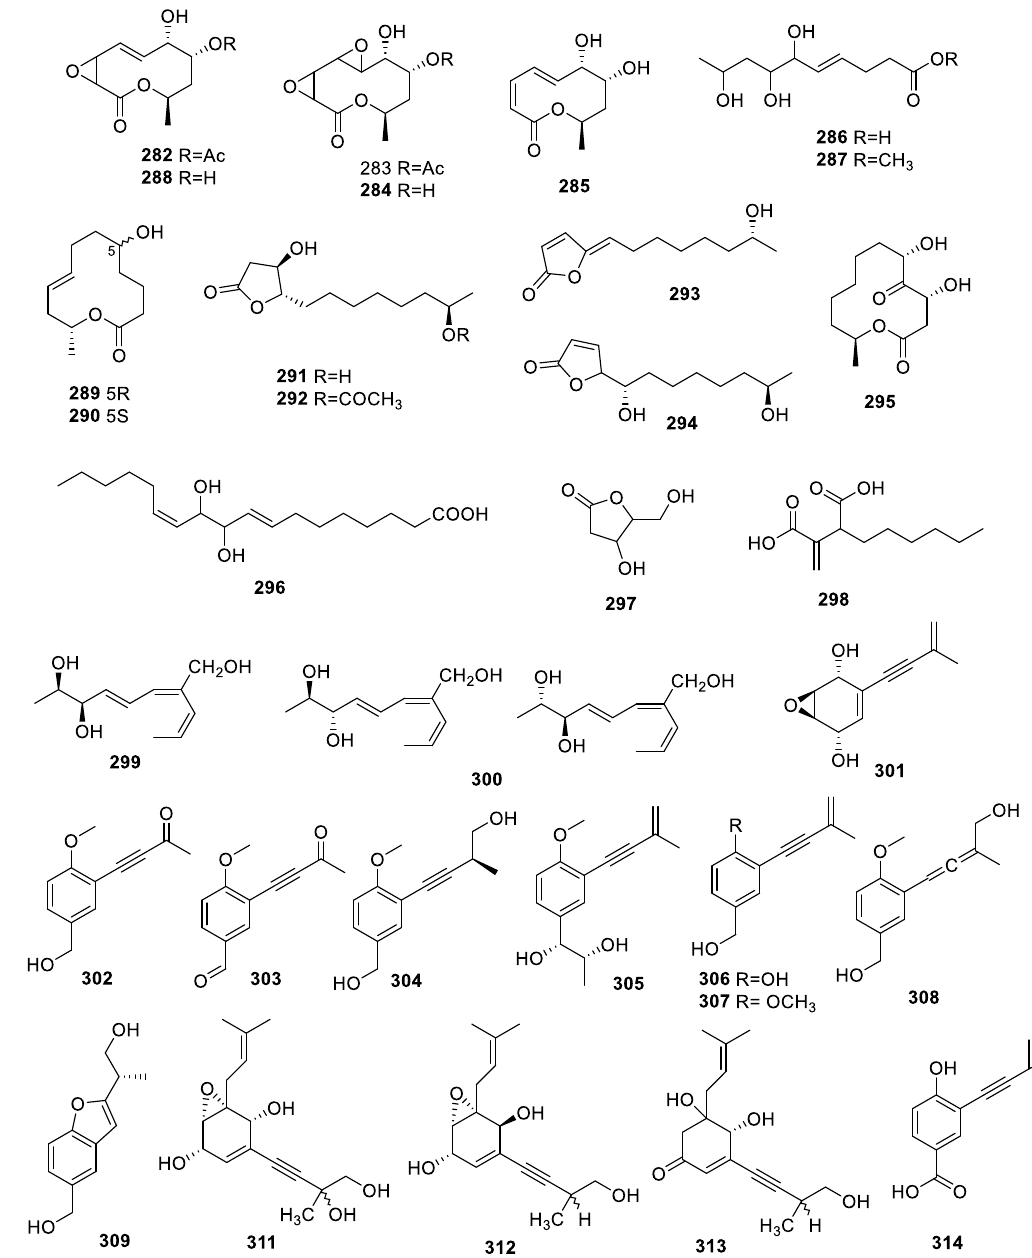
Figure 12. Chemical structures of other polyketides 282 – 309 , 311 – 314 . A study on Aspergillus flavus cf-5 from the red alga Corallina officinalis revealed the isolation of the new compound (8 E ,12 Z )-10,11-dihydroxyoctadeca-8,12-dienoic acid ( 296 ), which had a weak AChE inhibitory capacity with a rate of 10.3% at 100 µ g/mL [71]. 2 (cid:48) -Deoxyribolactone ( 297 ) and hexylitaconic acid ( 298 ) were identified from a